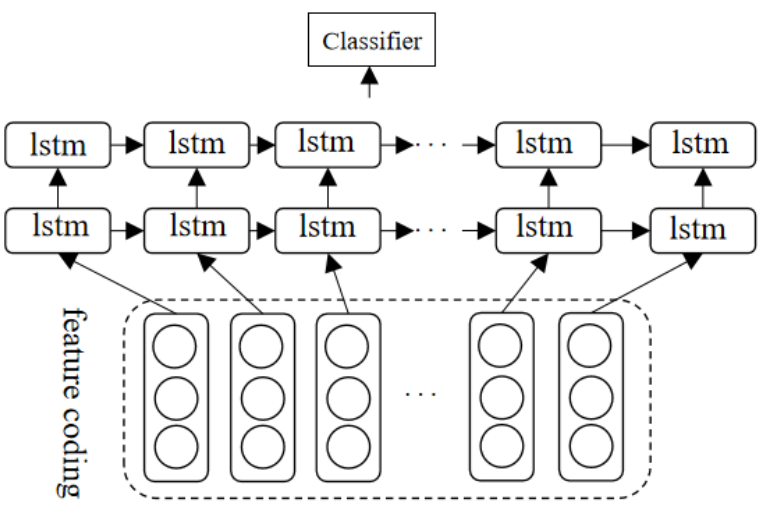
Figure 5. DHLSTM time sequence classifier [30].